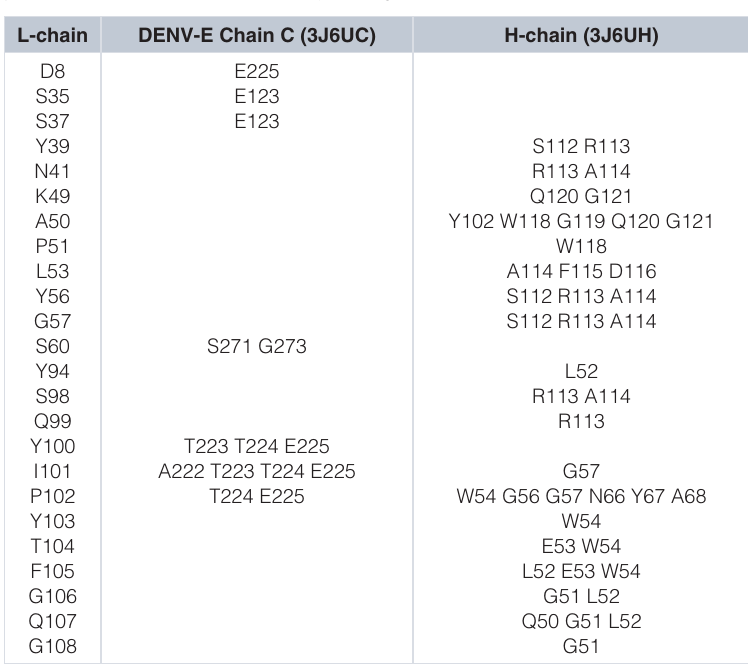
Supplementary Table 2. Interacting residues of the light chain (PDB ID:3J6UL) of the potent DENV antibody 5J7 with other subunits The C α atoms of interacting residues are within 8 Å of each other. The C-chain of the DENV-E protein interacts with both the heavy and light chains.